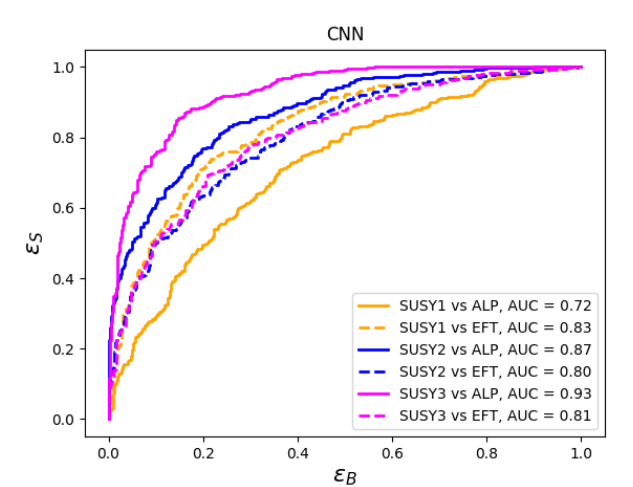
Figure 13: ROC curves (CNN with 2D histograms, r = 20) for signal versus signal for the dijet simulation. For these plots, 50K events are used for each